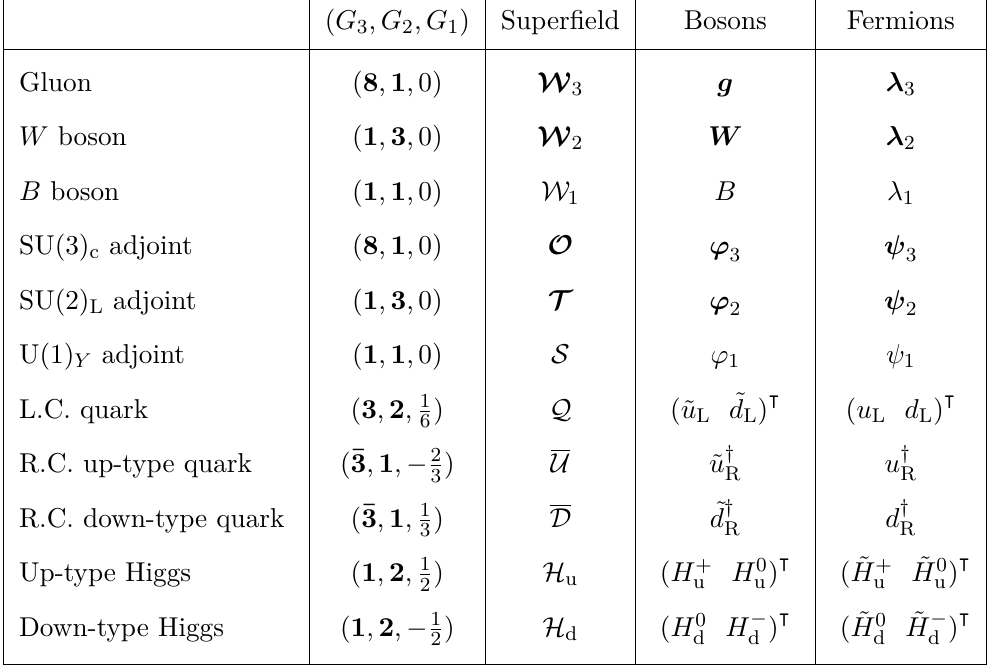
Table 1. Gauge group representations of selected fields in models where R symmetry is broken by the superpotential, the Majorana gaugino masses, and (unnecessarily) B µ . L.C. and R.C. stand for left- and right-chiral,